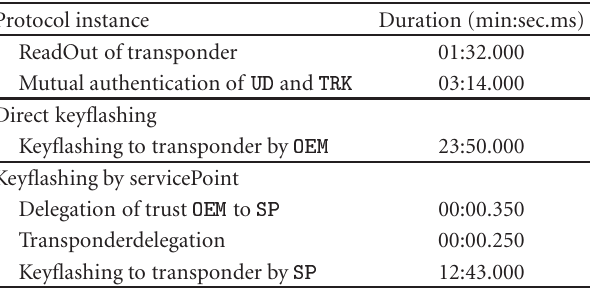
Table 8: Protocol execution